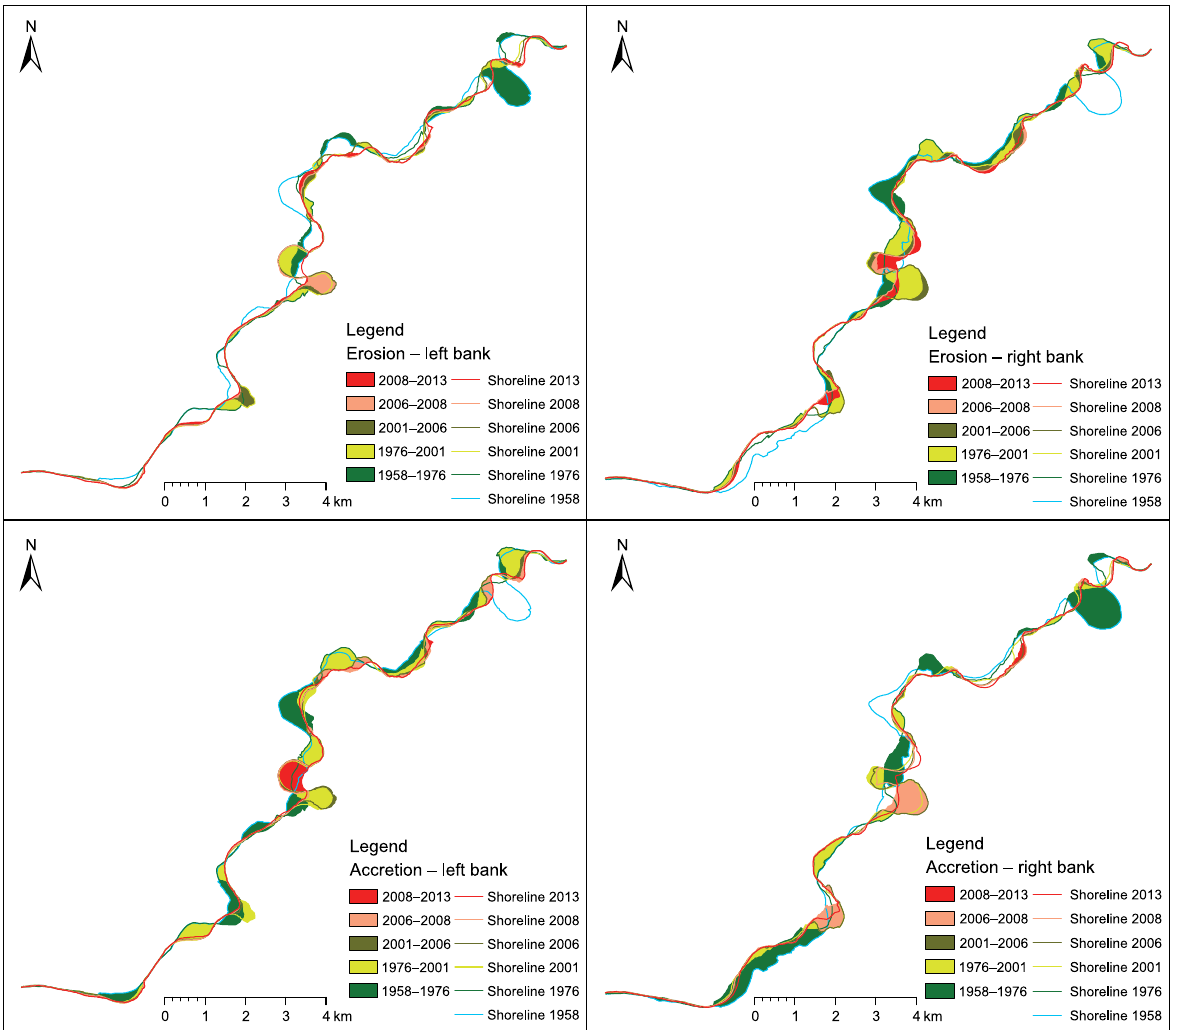
Fig. 2. Bank erosion and accretion during five periods from 1958 to